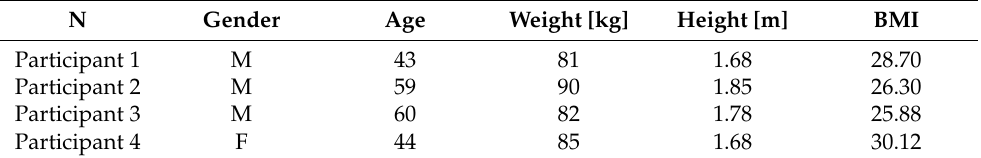
Table 1. Anthropometric parameters of participated subjects consisted of 3 males and females, age group 40–49, 50–59, and 60+. BMI—Body Mass Index is a measure of body fat based on height and weight that applies to adult men and women.